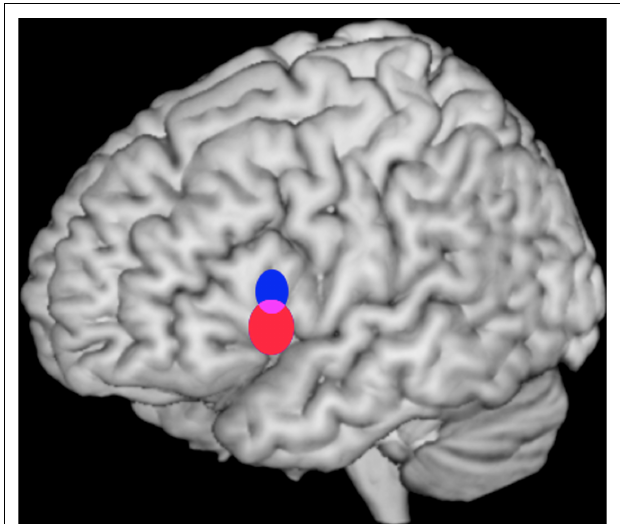
FIGURE 2 | Bootstrap 95% confi dence intervals for the mean locations of peak activations in a meta-analysis of phonological and semantic verbal fl uency activations in the left inferior frontal gyrus. Updated version of the analysis in Costafreda et al. (2006): the systematic literature search has been updated to September 2008 with a total of 25 studies included, and the bootstrap method has been modifi ed to take into account the clustered nature (activations within studies) of the data. The conclusions are the same as the ones in the published paper. Left lateral view of a rendered image of the brain (MNI template). The confi dence intervals (CI) for the mean location of peak BOLD responses associated with semantic verbal fl uency (red) were signifi cantly more ventral ( z -axis) than for those for phonological verbal fl uency (blue) at α = 0.05. Areas of intersections of the CI (phonological semantic) are shown in